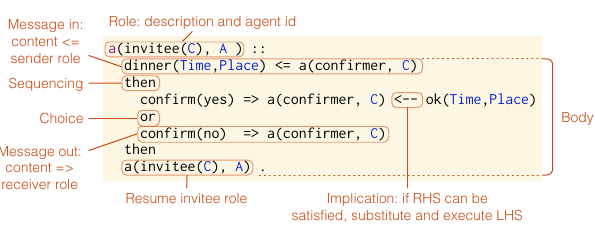
Figure 5. Example LSC clause from the meal organisation interaction model (slightly modified